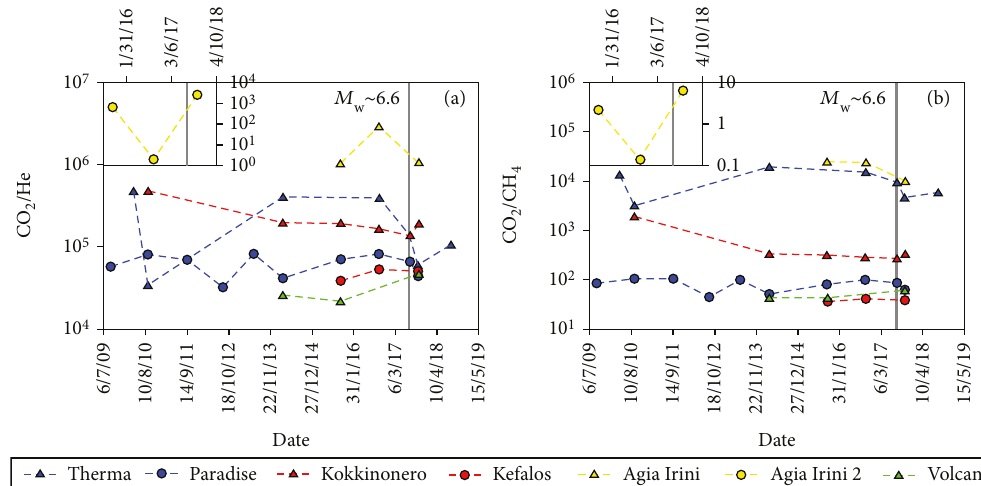
Figure 7: Time series plot of (a) CO Irini 2 being plotted in the inset. The seismic event on the 20 th July 2017 is noted with a gray